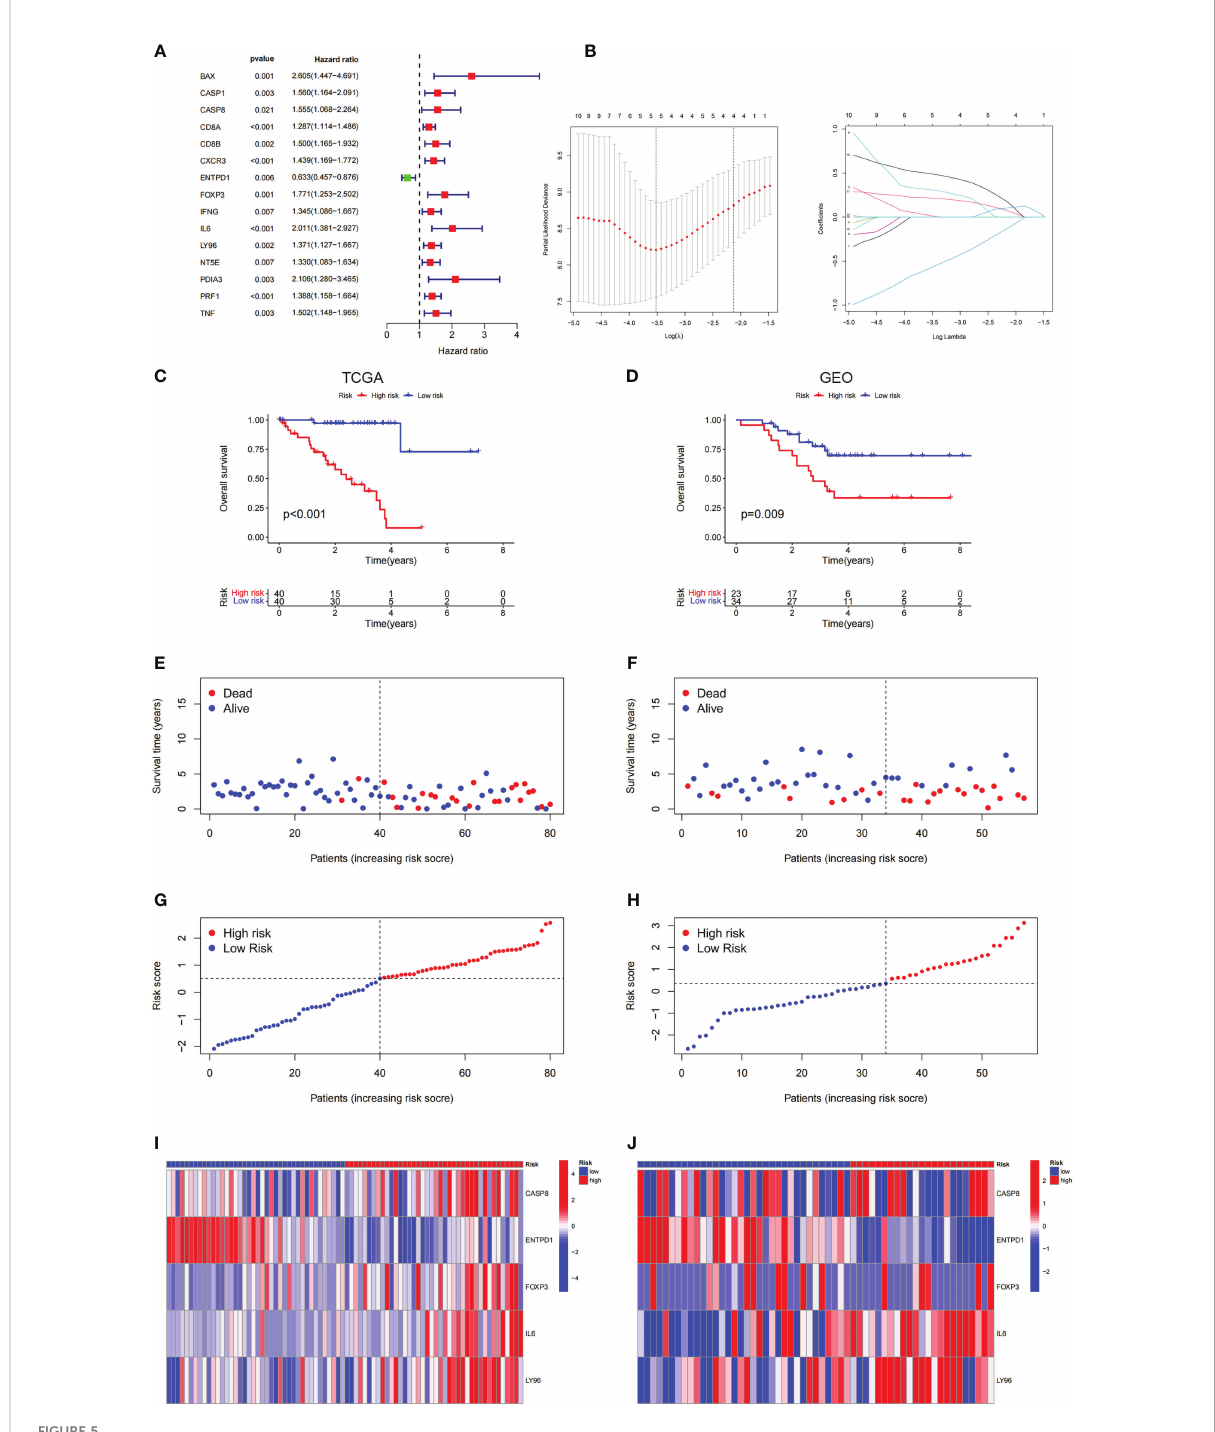
FIGURE 5 Construction and validation of the ICD-related risk signature. (A) The picture shows the overall survival (OS) forest plot obtained by univariate Cox analysis, which allows the assessment of the prognostic value of the ICD-related genes. (B) Lasso Cox analysis identi fi ed 5 ICD-related genes most associated with OS in the TCGA dataset. (C, D) Kaplan – Meier analysis of the prognostic signi fi cance of the risk model in TCGA and GEO databases. (E, F) The survival status of each patient in TCGA and GEO databases. (G, H) The distribution of risk scores in TCGA and GEO databases. (I, J) The heatmaps of prognostic 5 genes signature in the TCGA database and GEO